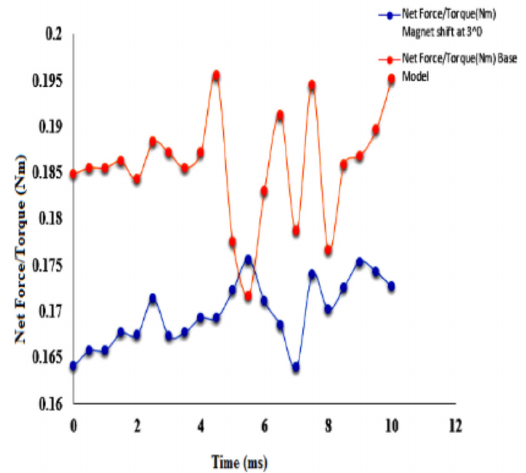
Figure 17. Load force/torque vs. time.